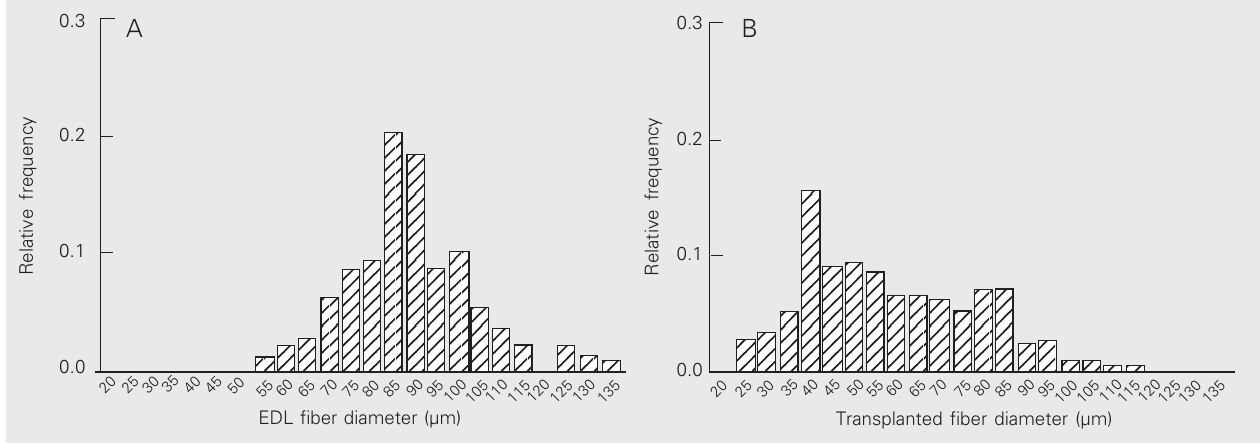
Figure 3. Frequency histograms of skeletal muscle fiber diameter. Sections obtained from adult male rat extensor digitorum longus (EDL) muscle (A) or from ectopic muscle 7 days after transplantation (B) were stained with hematoxylin and eosin and photographed with 40X objectives and the fiber diameter was measured using public domain NIH-Image 1.61